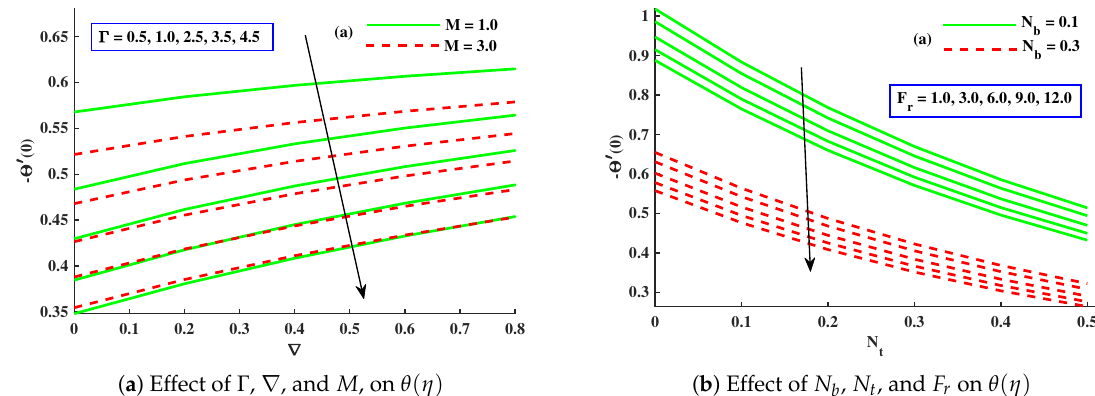
Figure 11. Curves of θ ( η ) with Γ , ∇ , M , N b , N t , and F r .